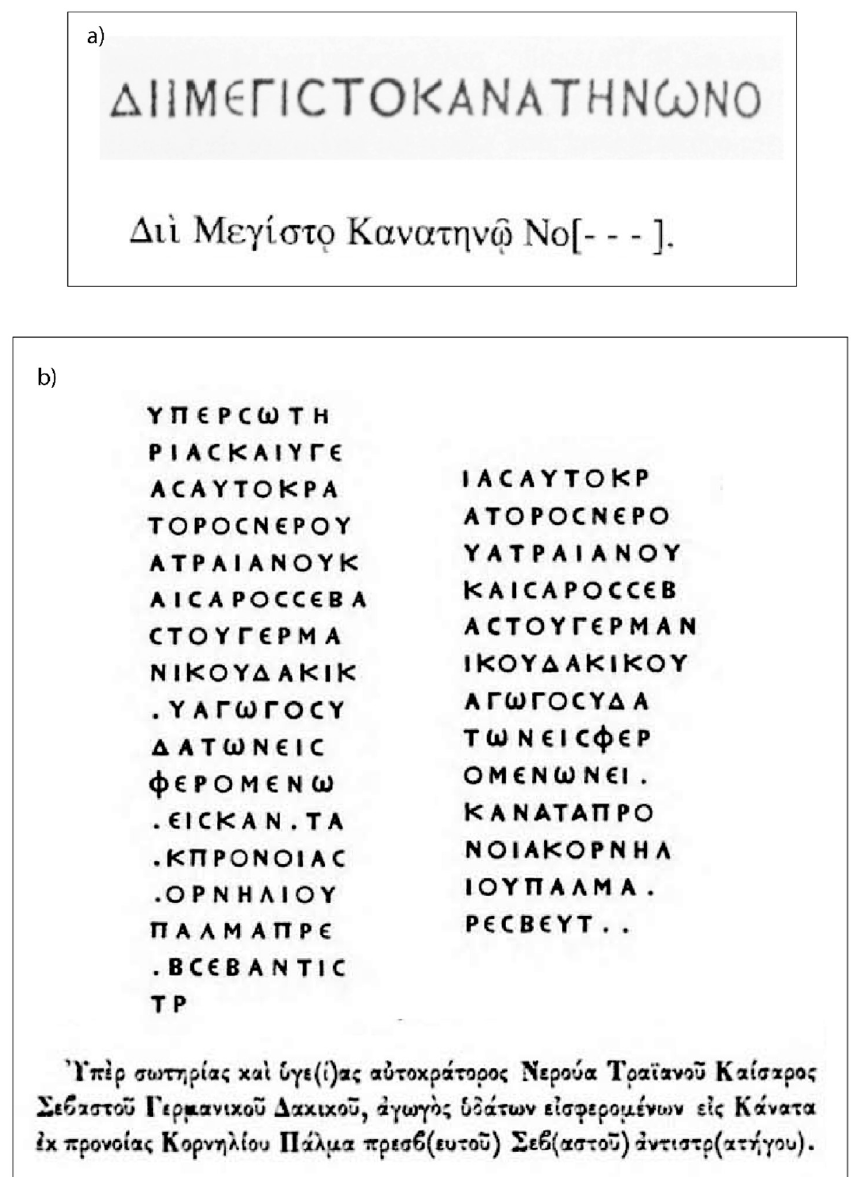
Figure 7. Inscriptions pointing to bi-directional relationships between the settlements. ( a ) The people from Kerak in the plain of Nuqra worship Zeus Megistos at Kanatha, located 20 km to the east of Kanatha, from where it received water. [86] (no. 2412d), [85] (no. 9799). ( b ) Inscription from Aphetata/el-Afineh about the channels of water ( agogoi hydat ô n ) from Kanatha. [86] (no. 2296.